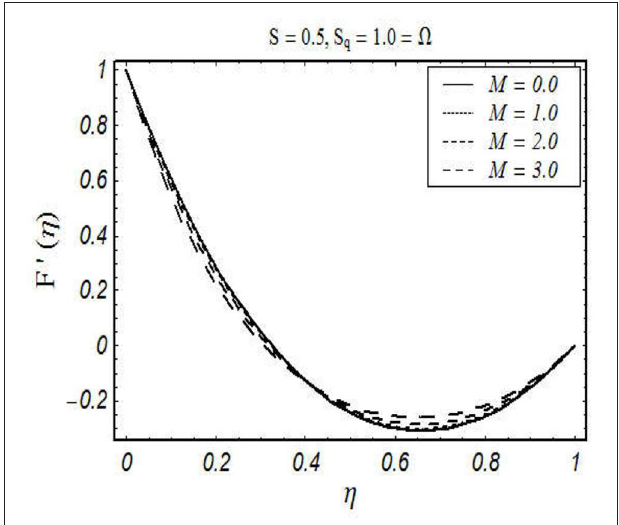
FIGURE 5 | Sketch of velocity distribution G (η) for magnetic number M .